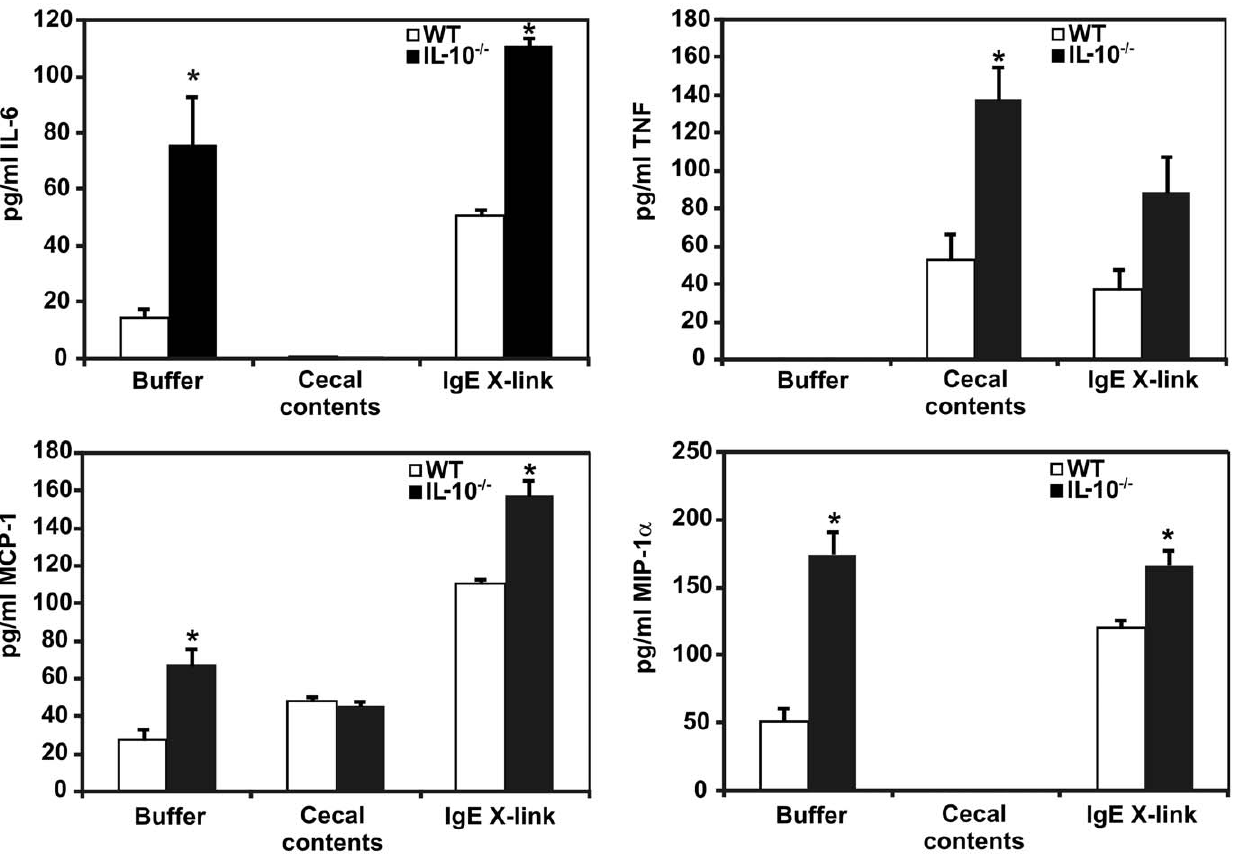
Figure 1. BMMC cytokine production after stimulation with IgE or enteric bacteria. BMMC were stimulated for 4 hrs, then media was harvested for cytokine analysis via Luminex bead-based fluorescent immunoassays. Il10 2 / 2 BMMC make more IL-6, MCP-1, and MIP-1 a constitutively (buffer treatment) and following IgE stimulation than WT BMMC ( p , 0.05). Exposure to enteric bacteria in cecal contents triggers a different pattern of cytokine expression, with higher TNF production by Il10 2 / 2 vs. WT BMMC. Data shown is the mean 6 SEM for 3–5 independent experiments. * indicates p # 0.05 vs. WT.